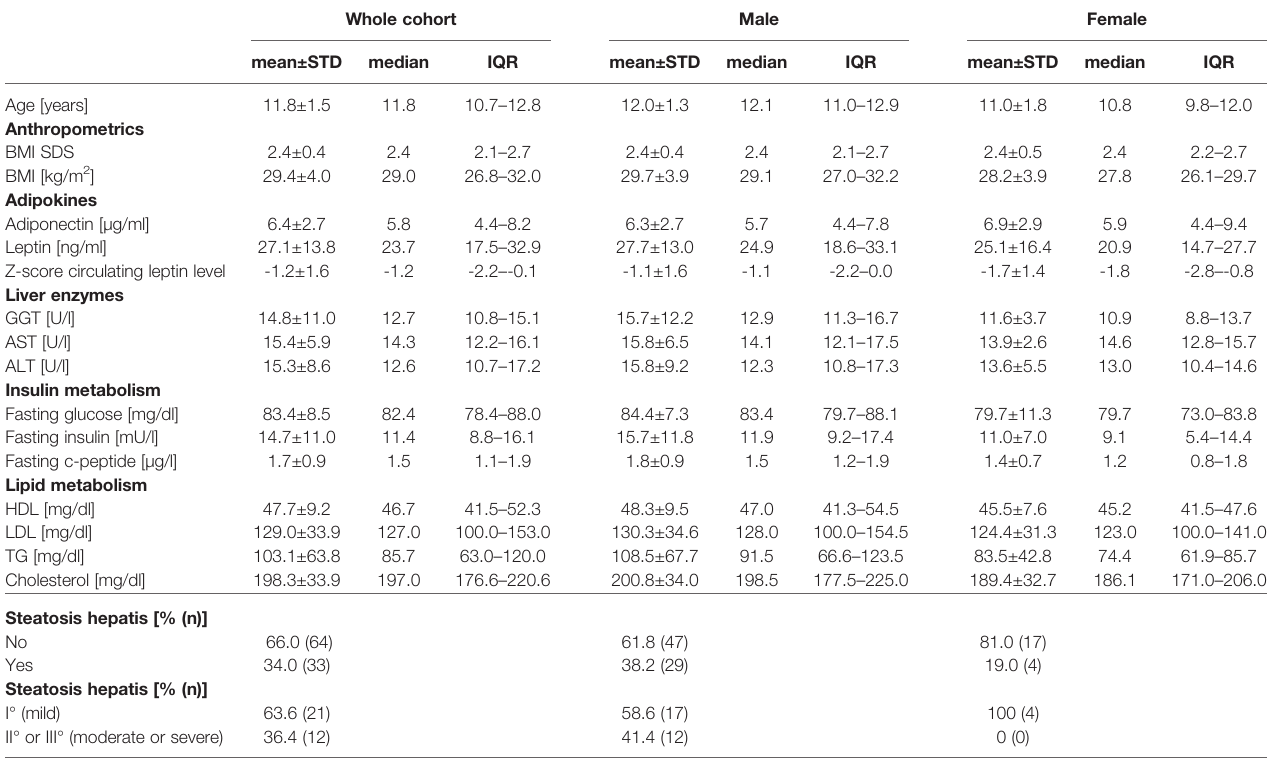
TABLE 1 | Description of the anthropometric and metabolic parameters (adipokine concentration, concentration of liver enzymes, insulin and lipid metabolism), as well as of the distribution of pre-pubertal children with obesity and with steatosis hepatis in the whole cohort (n=97), as well as separated for males (n=76; 78.4% of cohort) and females (n=21; 21.6% of